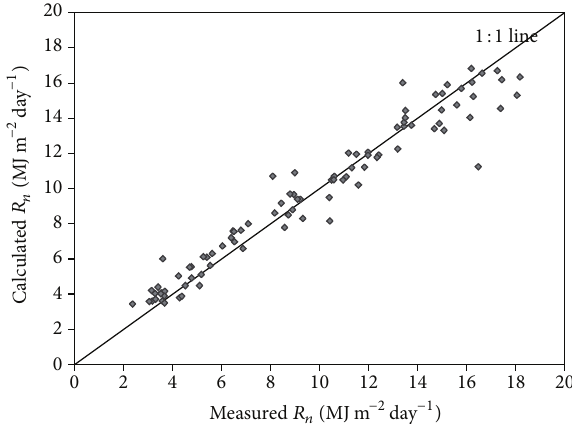
Figure 3: The observed and estimated 𝑅 𝑛 values in 2005 and